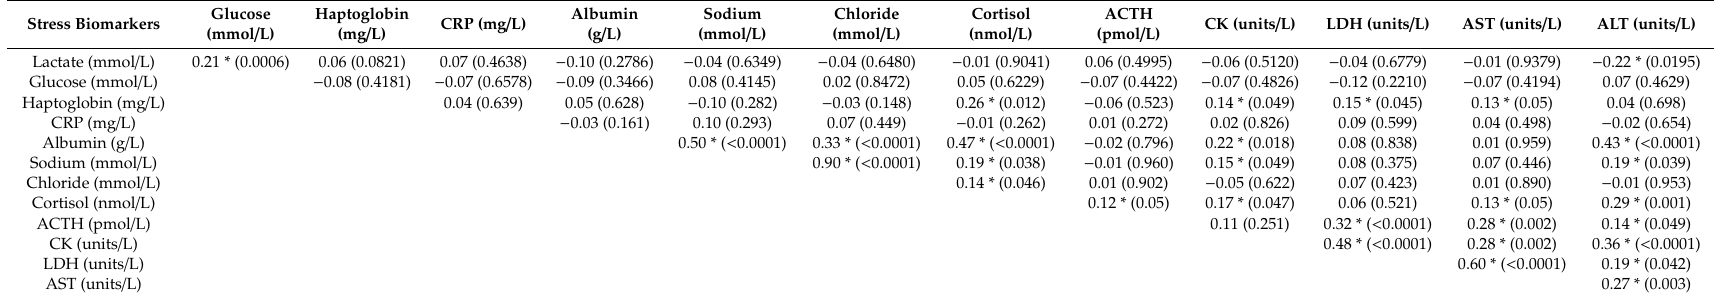
Table 8. Interrelationships (r) between physiological stress biomarkers in slaughter